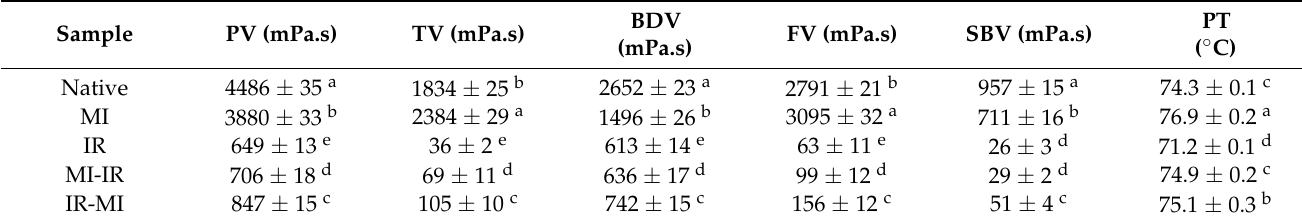
Table 2. Pasting properties of native and modified lotus rhizome starches.